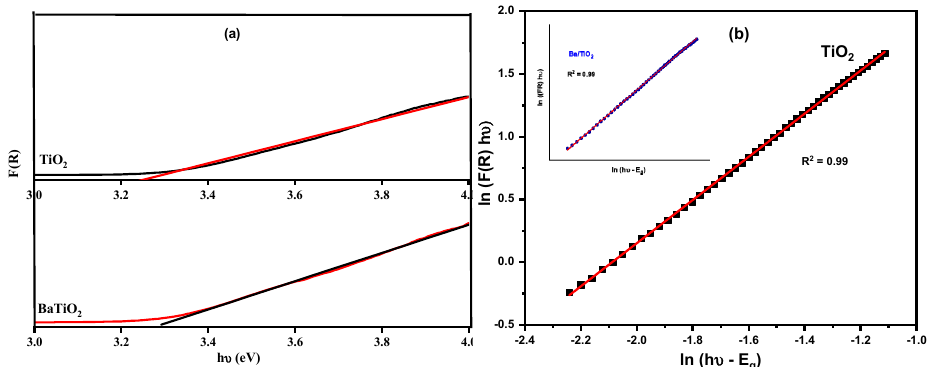
Figure 3. ( a ) Tauc plots of synthesized TiO 2 and Ba/TiO 2 photoanodes ( b ) Graphical representation of Equation (7), inset relates to Ba/TiO 2 . Table 2. n coefficient determination and band gap.